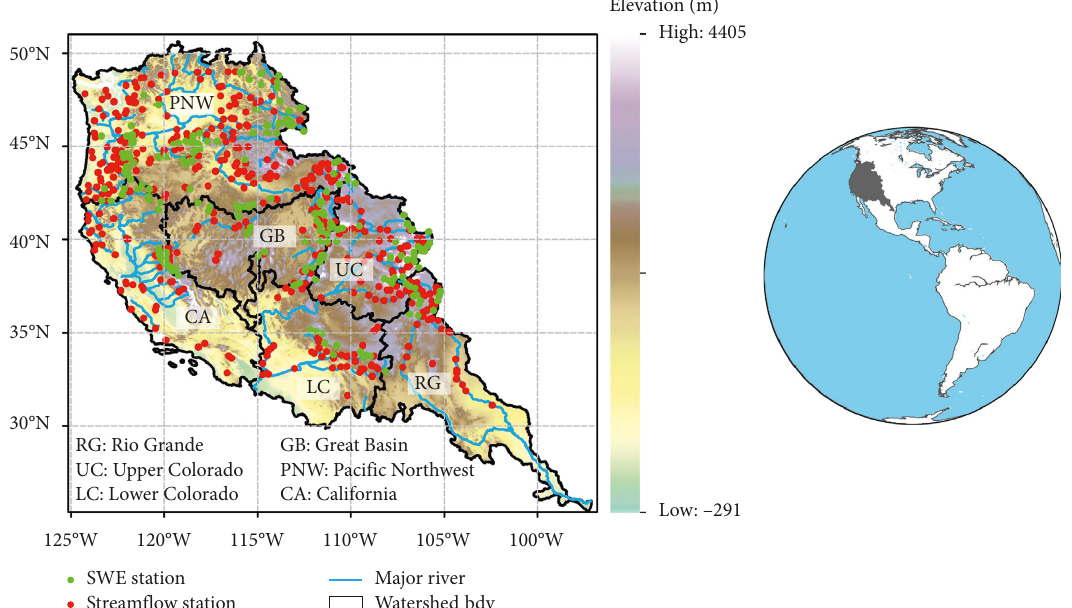
Figure 1: Research area, station distribution, and the location of the study area in global (gray area in western hemisphere). Table 1: Numbers of SNOTEL and streamflow stations used in this study.